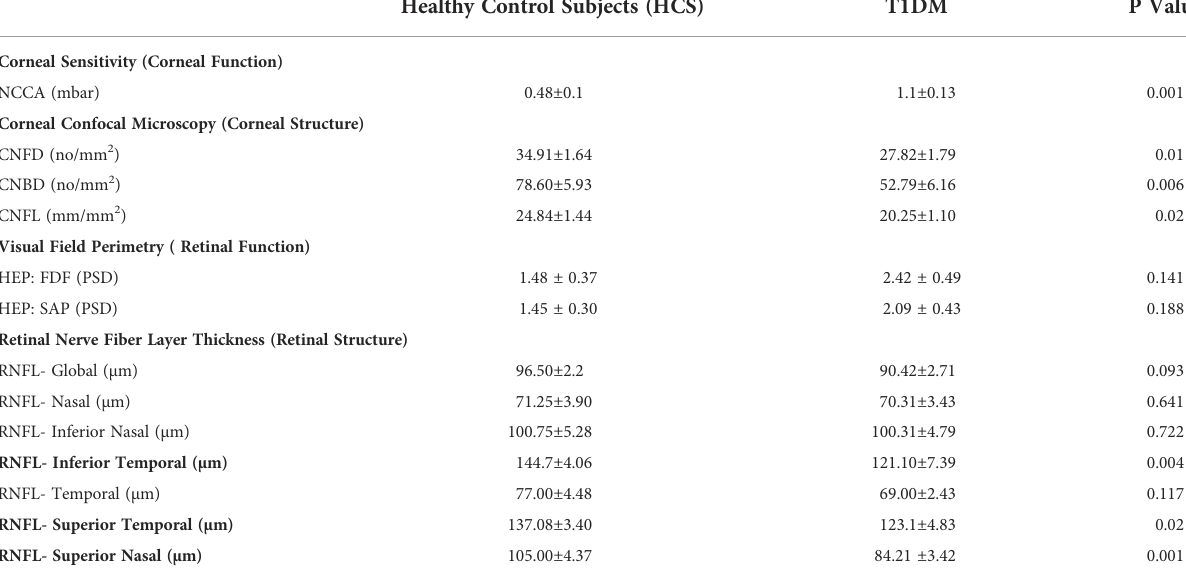
TABLE 2 Corneal and retinal nerve fi ber layer functional & structural